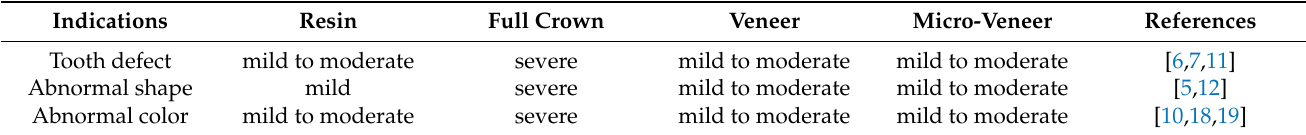
Table 1. The difference of indications for resin, the full crown, veneer, and micro-veneer.